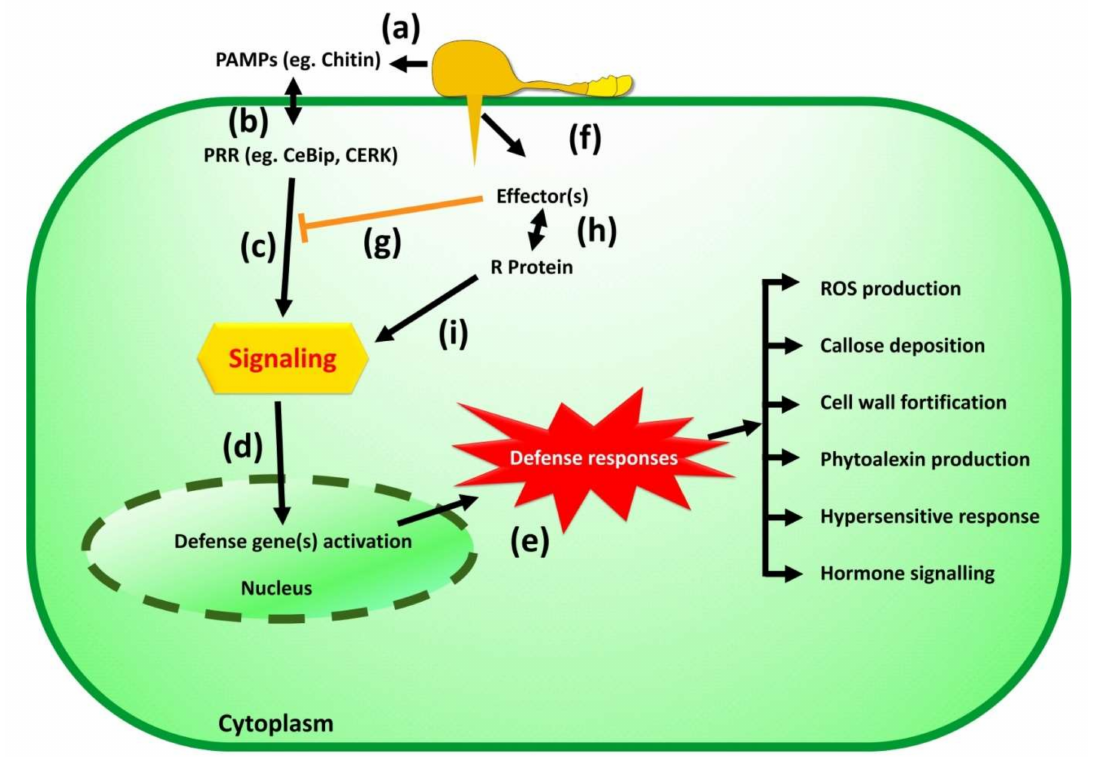
Figure 2. Overview of rice defense system against blast pathogen Magnoporthe oryzae . ( a ). PAMPs molecules present on membrane of Magnaporthe spore. ( b ). PRR presents on the rice cell membrane help to recognize PAMP molecules. ( c ). A successful recognition by PRR triggers PTI (PAMP-triggered immunity) and activates resistance signaling cascade. ( d ). Resistance signaling activates defense gene in nucleus of rice. ( e ). Defense responses includes ROS production, Callose deposition, Cell wall fortification, Phytoalexin production, Hypersensitive response, Hormone signaling etc. ( f ). In order to avoid recognition of PAMP molecules by PRR, Magnaporthe secretes effectors molecules. ( g ). Effectors molecules inhibit PTI responses which known as effector triggered susceptibility (ETS). ( h ). Plant resistant gene recognize effectors of pathogen which known as effector triggered immunity (ETI). ( i ). Successful recognition of effectors molecules by R gene activates resistance signaling